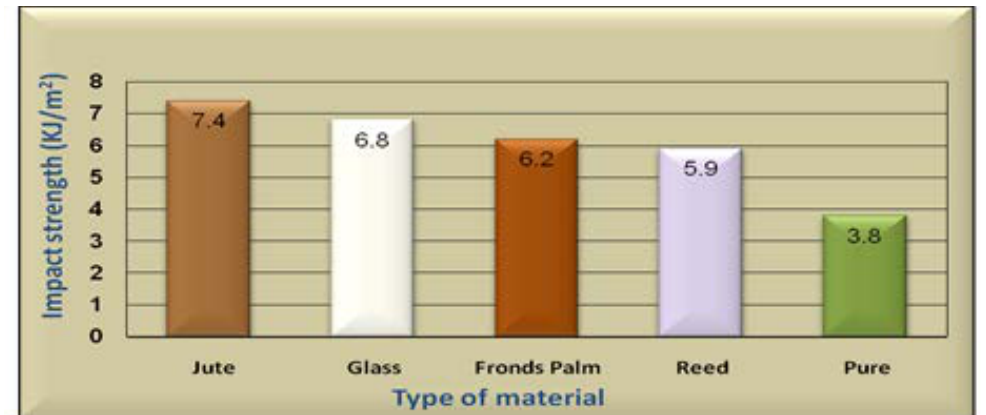
Fig.7: Comparison between the (F.S) for natural fibers with Glass fibers